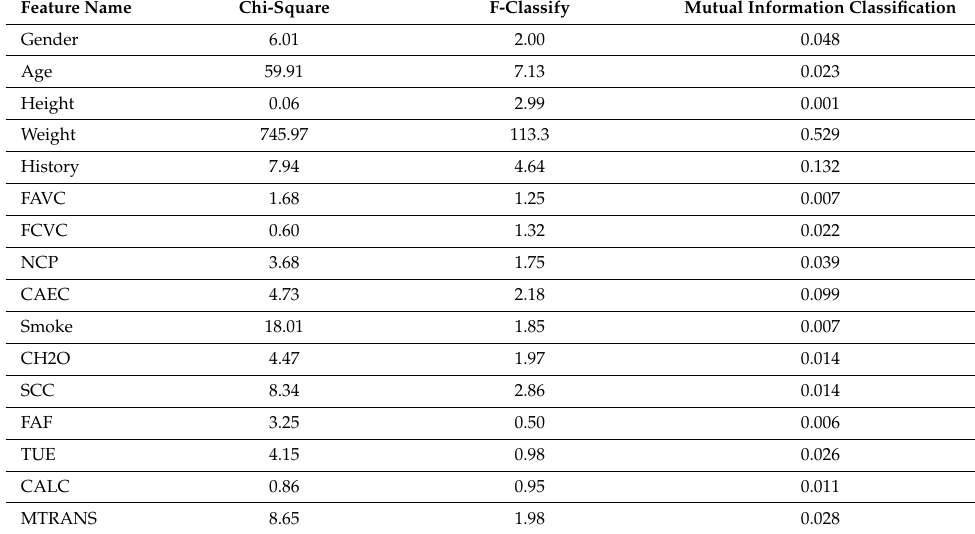
Table 5. Results of feature importance scores for feature selection